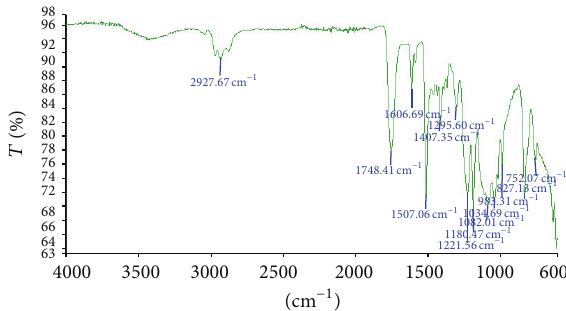
Figure 6: ATR-FTIR spectrum of the underlying layer of the unaffected zone.